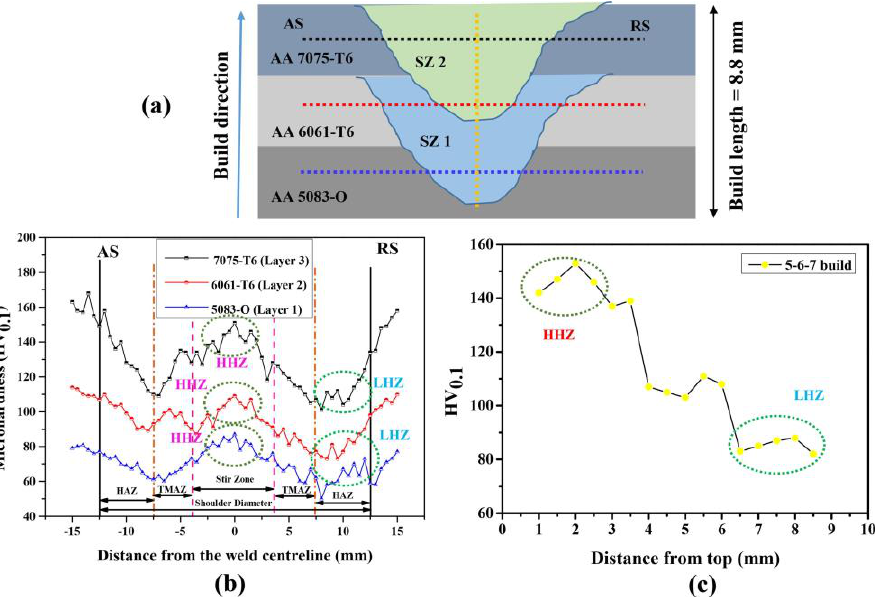
Figure 17. Microhardness variation of a fully gradient laminate: ( a ) complete build with plate or- der; ( b ) microhardness variation of NZ from the center; ( c ) NZ hardness variation with respect to the building height. (reprinted from [92] with permission from Elsevier).